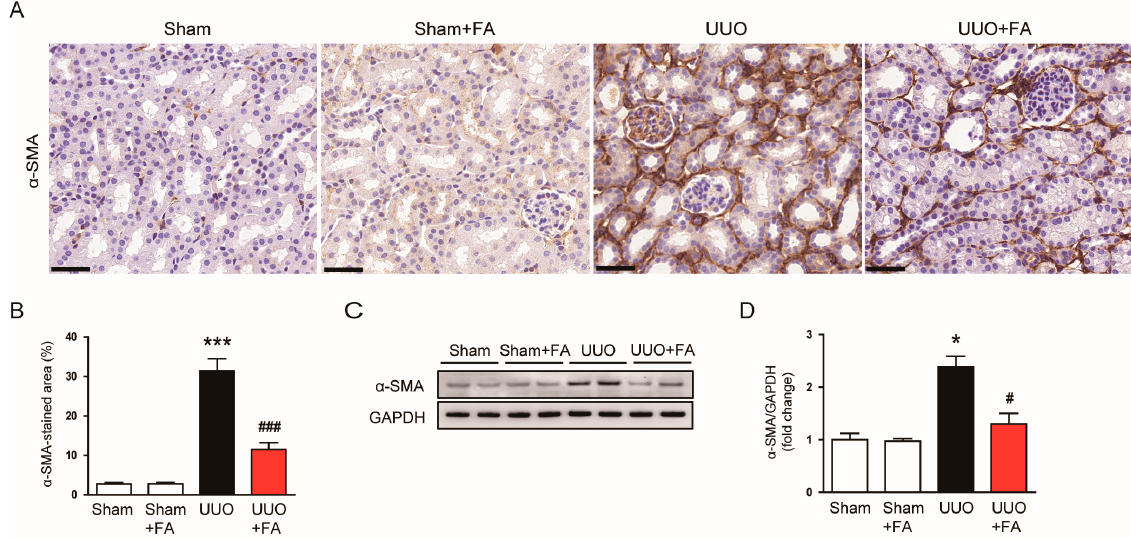
Figure 5. Effects of FA on myofibroblast accumulation in UUO mice. ( A ) IHC staining for α - SMA. Scale bar = 40 µ m. ( B ) Percentages of α -SMA-stained area. ( C ) Western blotting of α -SMA. ( D ) Quantification of Western blots for α -SMA. * p < 0.05 and *** p < 0.001 vs. Sham. # p < 0.05 and ### p < 0.001 vs.